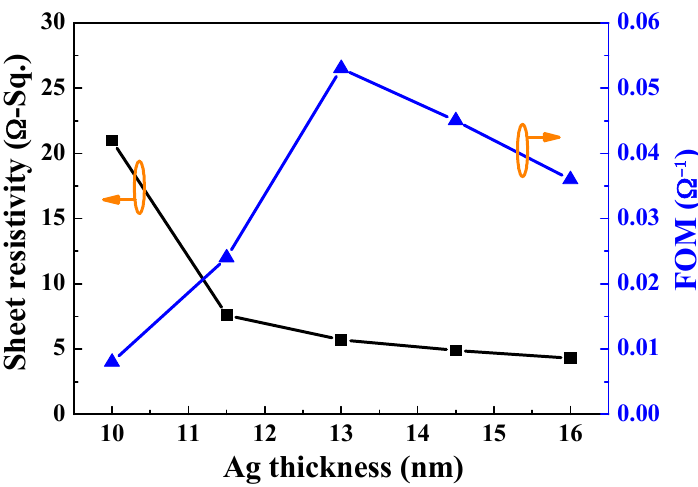
Figure 6. FOM values of the α -IGZO/Ag/ α -IGZO triple-layer structure as a function of thickness of Ag film.